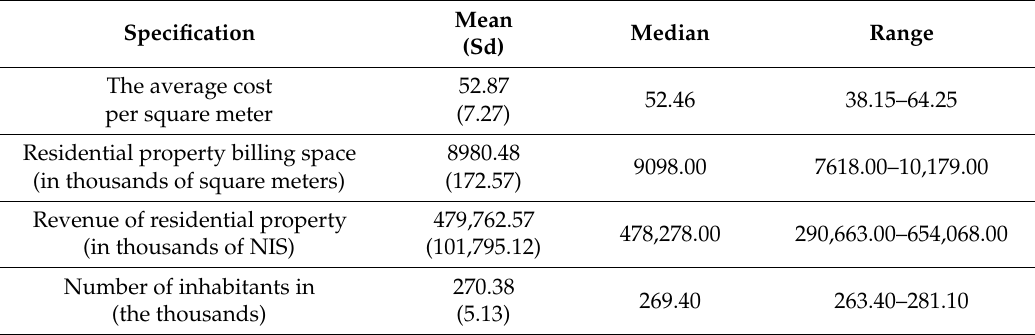
Table 3. Descriptive statistics of the variables for the city of Haifa.